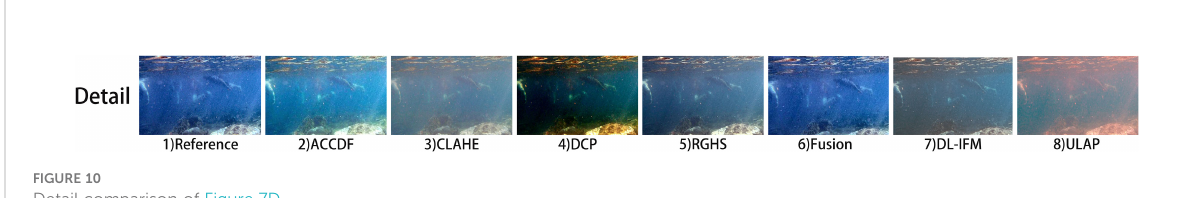
FIGURE 10 Detail comparison of Figure 7D.